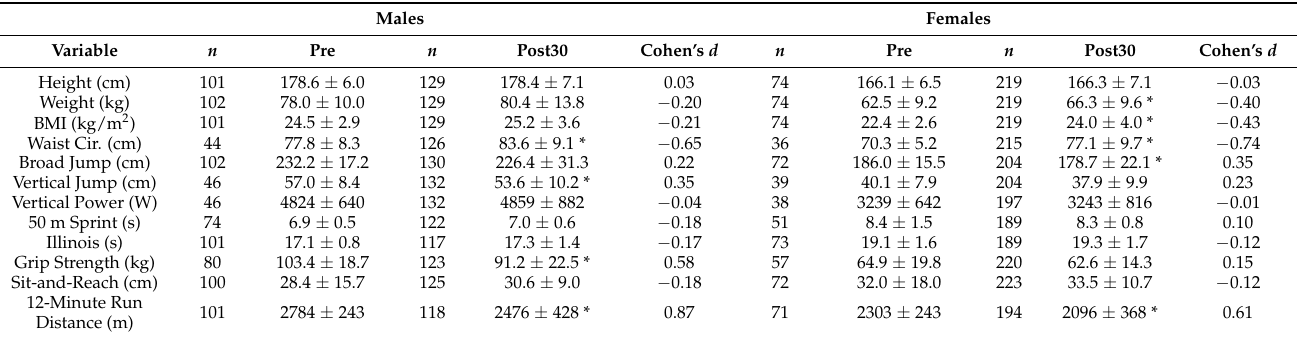
Table 1. Anthropometric and physical fitness comparison of undergrade students measured 30 years